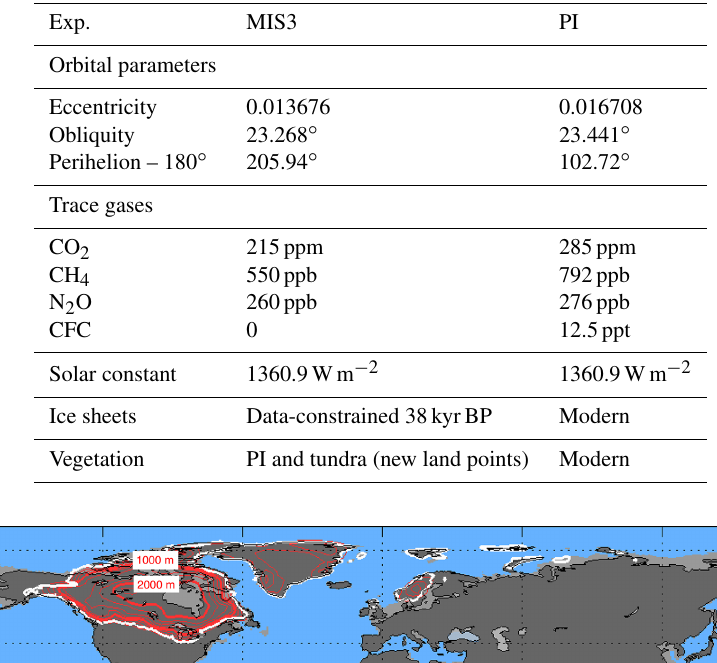
Table 1. Forcings and boundary conditions for the MIS3 and PI simulations.